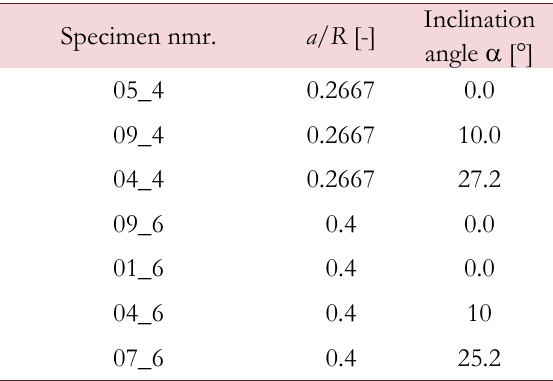
Table 3: The relative length of notch in Brazilian disc specimens and angle of used angle